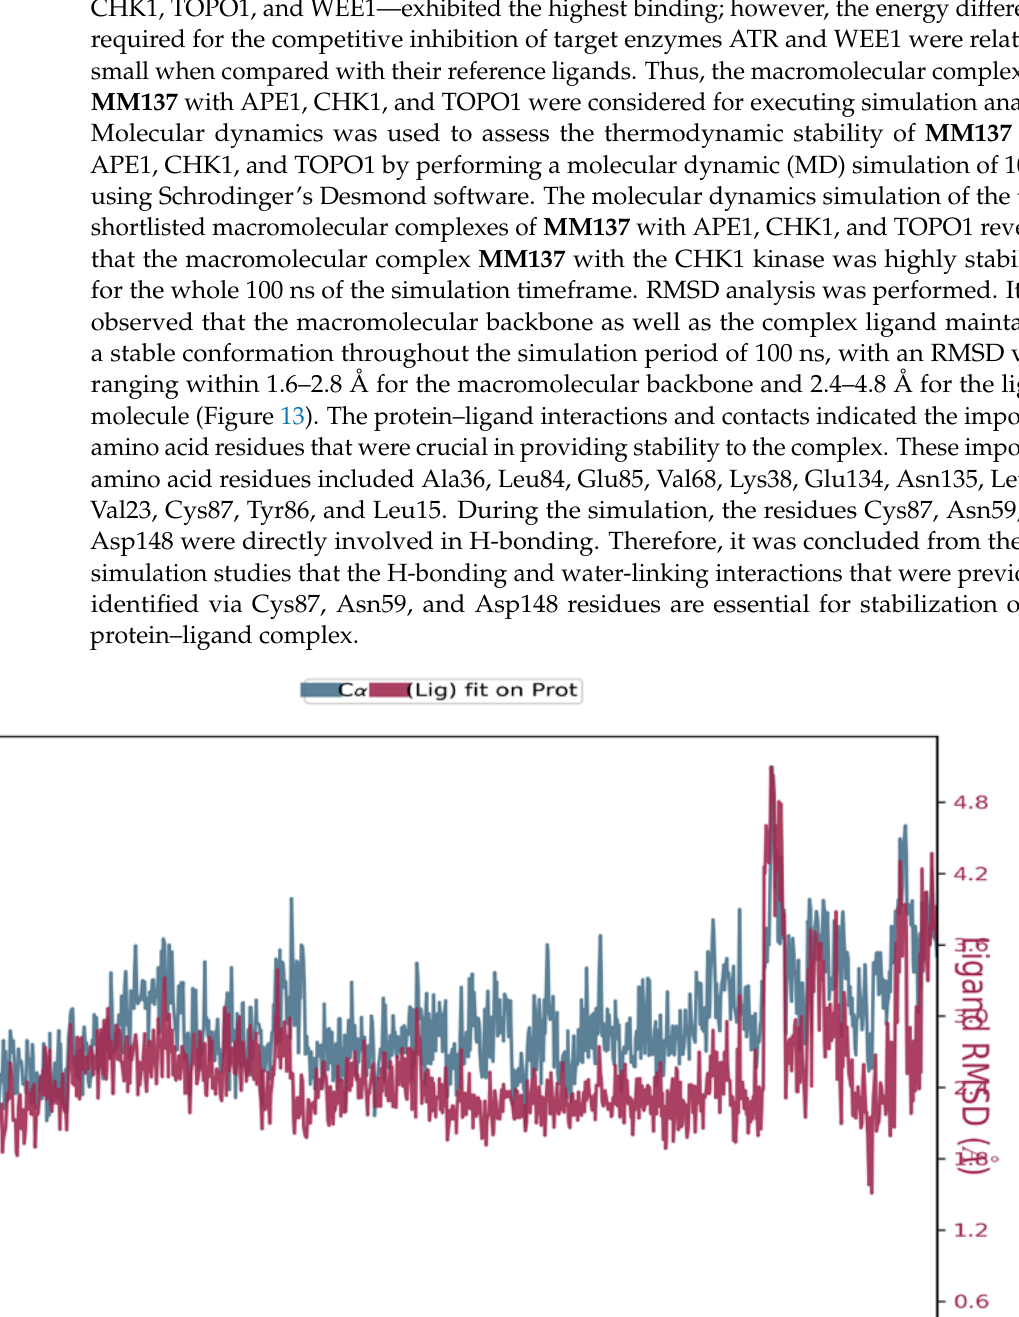
Figure 12. Graphical representation of molecular docking results: two-dimensional binding interac- tions of MM137 with human APE1 ( a ), CHK1 ( b ), and TOPO1 ( c ).